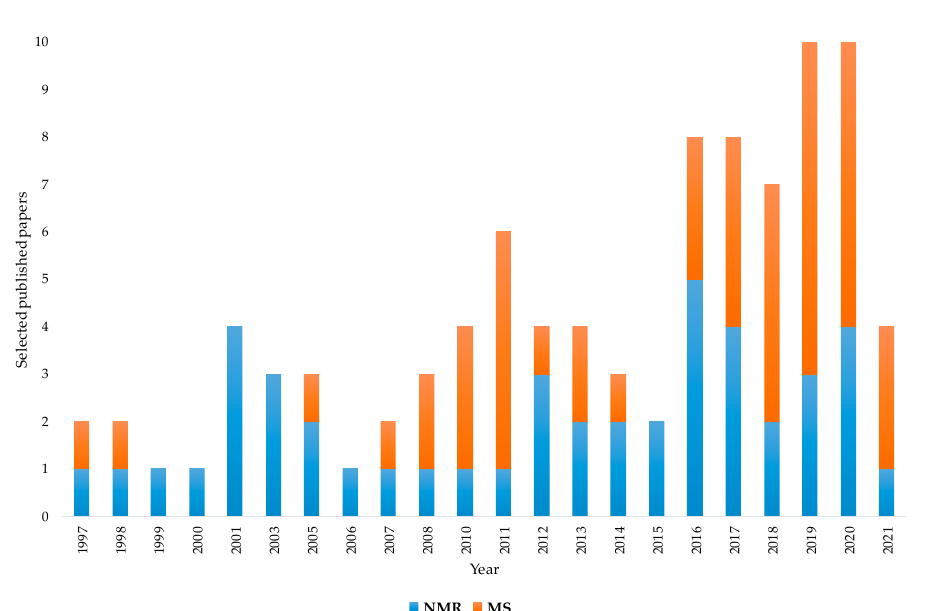
Figure 5. Temporal distribution from 1997 to 2021 (to date) of selected NMR- and MS-based studies for geographical origin assessment of EVOOs. Data from systematic research on https://www.scopus.com/ and https://scholar.google.com/ (accessed on 1 December 2021).